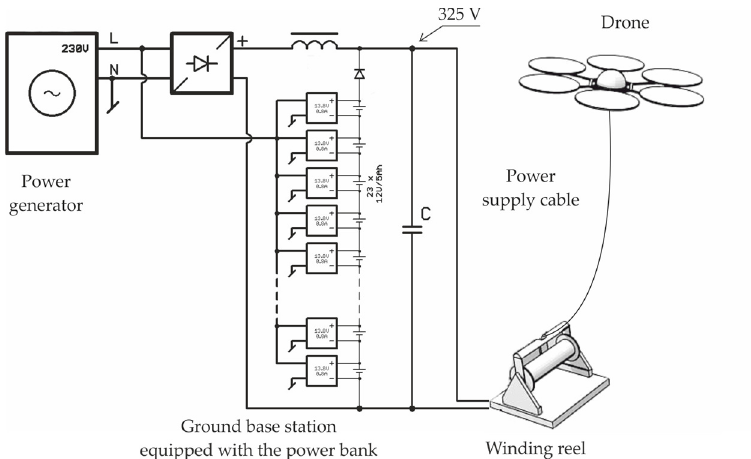
Figure 2. Basic blocks of the modular surveillance system supplied from the ground power supply